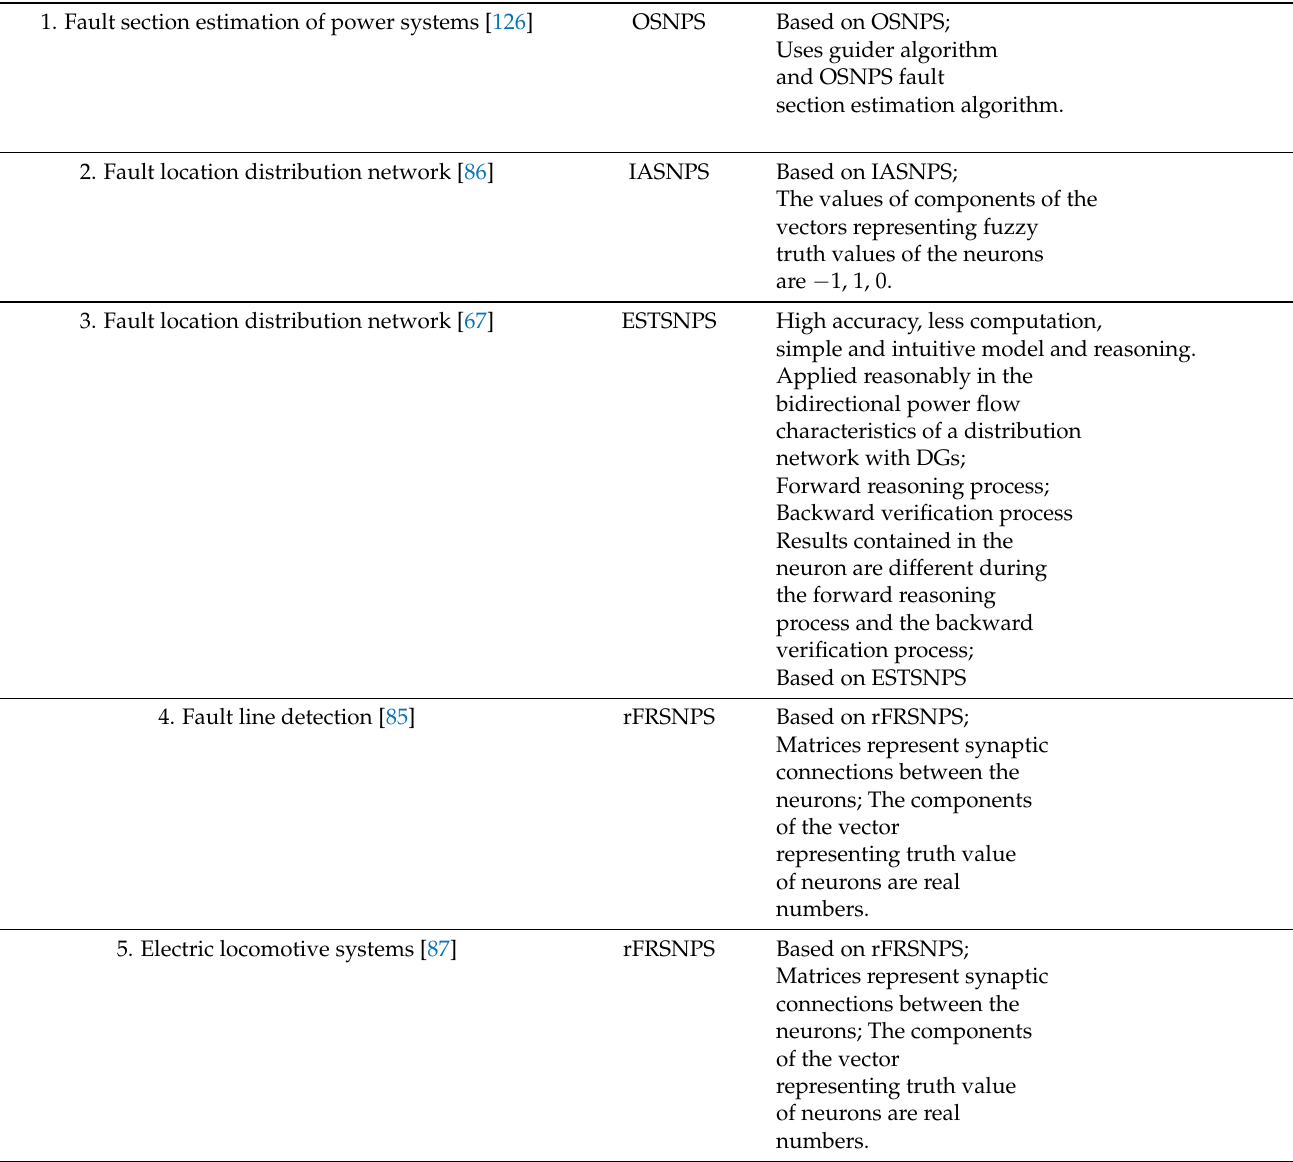
Table 9. Comparisons of reasoning algorithms for other types of power